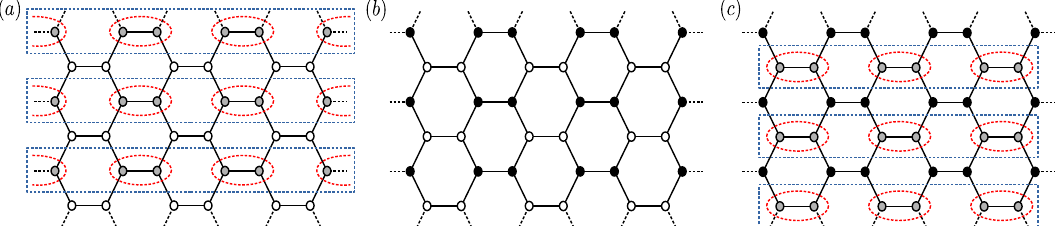
Figure 3: Spatial structures of the insulating phases: (a) The dimer insulator at den- sity ρ = 1 / 4; (b) Charge-density-wave insulator at half-filling; and, (c) The dimer insulator at filling fraction 3 / 4. The red dashed lines depict the formation of dimers. The white, grey and black circles signify lattice sites with density 0.0, 0.5 and 1.0 re- spectively. The blue dashed rectangles represent the underlying 1D SSH-like chains, at their, (a), topological and, (c), non-topological phases.